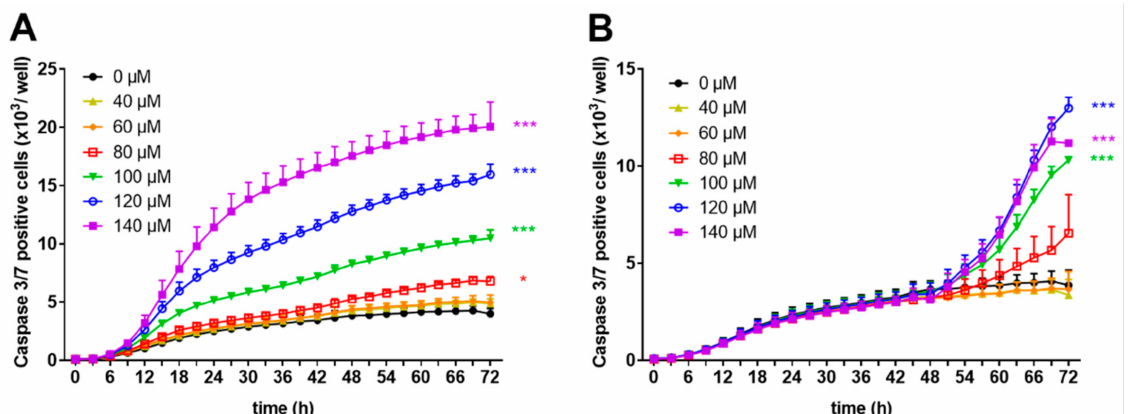
Figure 5. Zinc aspartate activated caspase-3 and caspase 7 in freshly stimulated and pre-activated T cells. Human resting T cells were freshly stimulated ( A ) or pre-activated for 48 h ( B ) with anti-CD3/CD28 antibodies and cultured with increasing concentrations of zinc aspartate. For kinetic analyses, T cells were cultured with increasing concentrations of zinc aspartate in the presence of Caspase-3/7 reagent. Kinetic measures of the number of caspase 3/7 positive cells were recorded by the IncuCyte S3 imaging system at 3 h intervals for 72 h. Data are presented as the mean + SEM from three independent experiments. (* p < 0.05, *** p <